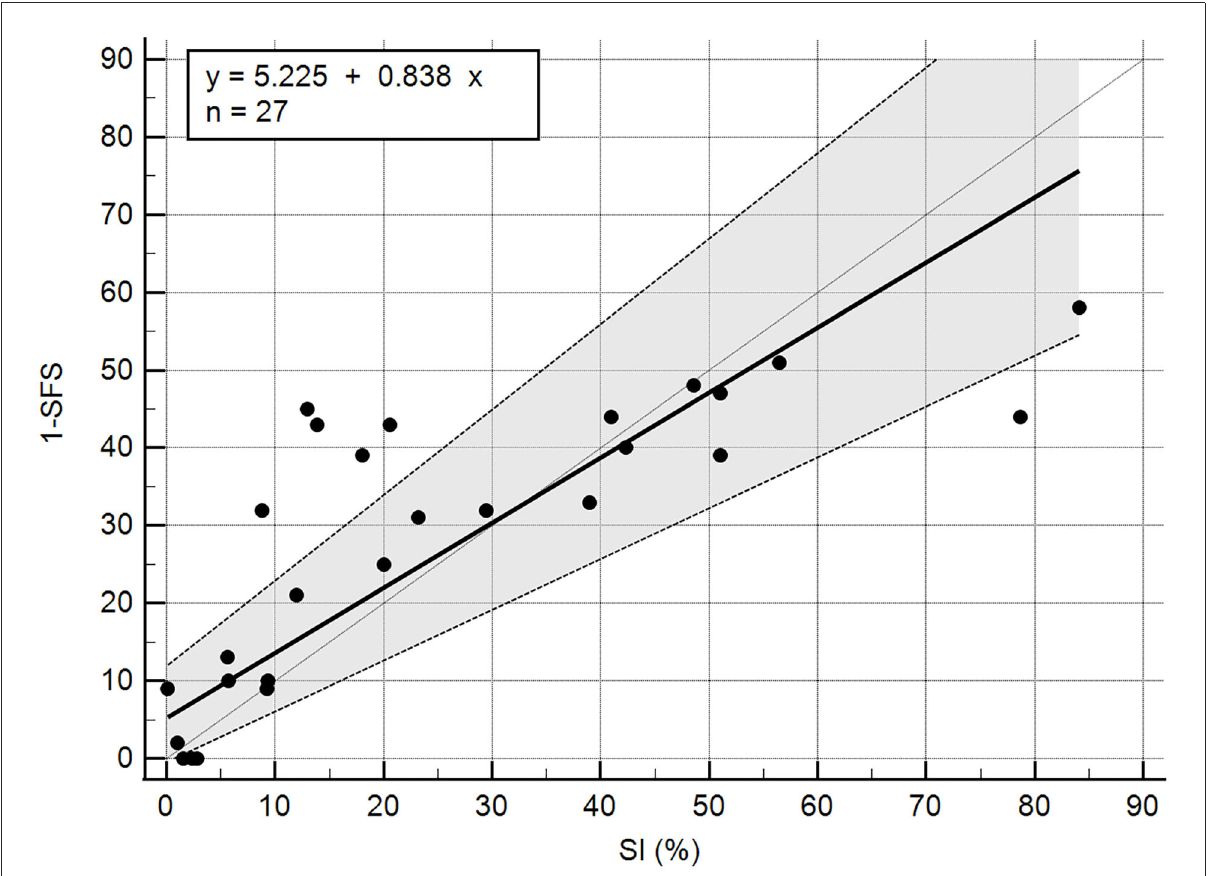
FIGURE1 Passing Bablok regression of 1-SFS and SI